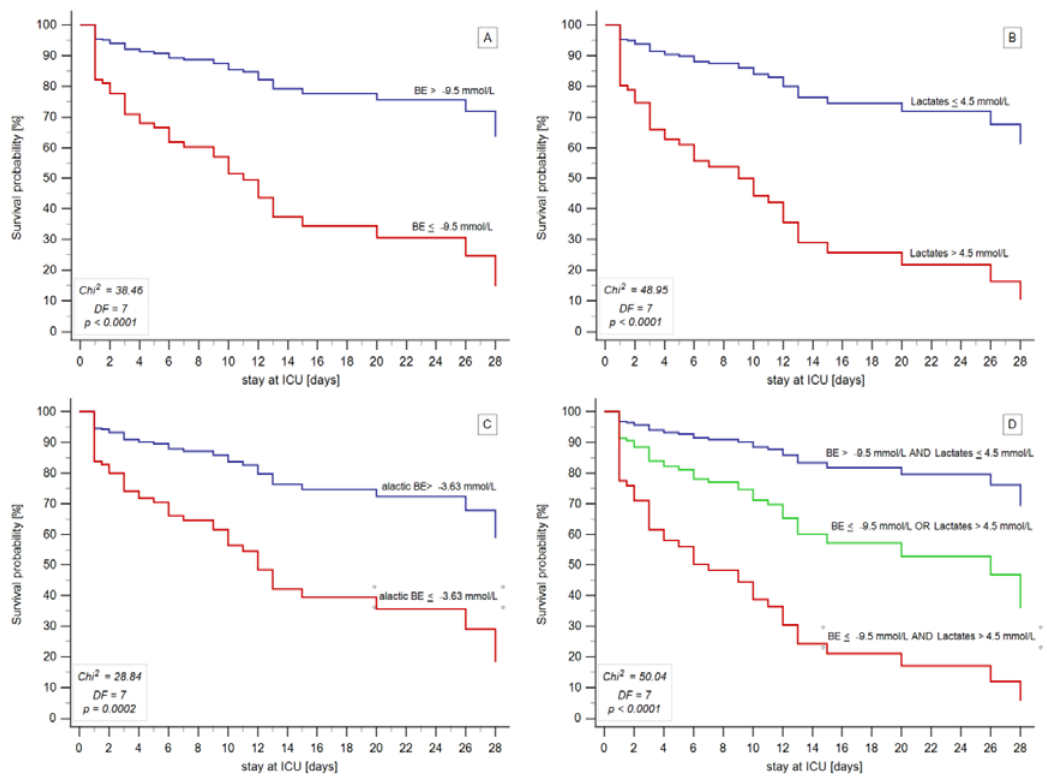
Figure 2. Comparison of survival curves modelled by the Cox proportional hazard regressions for the 28-day ICU mortality in shock patients, stratified according to the admission values of BE (Panel ( A )), lactate concentration (Panel ( B )), aBE (Panel ( C )), and the combination of BE and lactate concentration (Panel ( D )) based on cut-off values defined by the ROC analysis. Red lines correspond to patients with the highest risk, whereas blue lines correspond to those with the lowest risk. The green line in Panel ( D ) corresponds to the middle-risk group (category 1). Values of chi 2 , degrees of freedom (DF), and p for the models are shown in the bottom-left corners of each panel. Abbreviations: BE—base excess; aBE—alactic base excess, DF—degrees of freedom; ICU—intensive care unit. As BE and lactate concentrations (dichotomised according to their cut-off values) have prognostic values both as single covariates or combined into categories, it was also investigated whether they were simultaneously independent of one another and